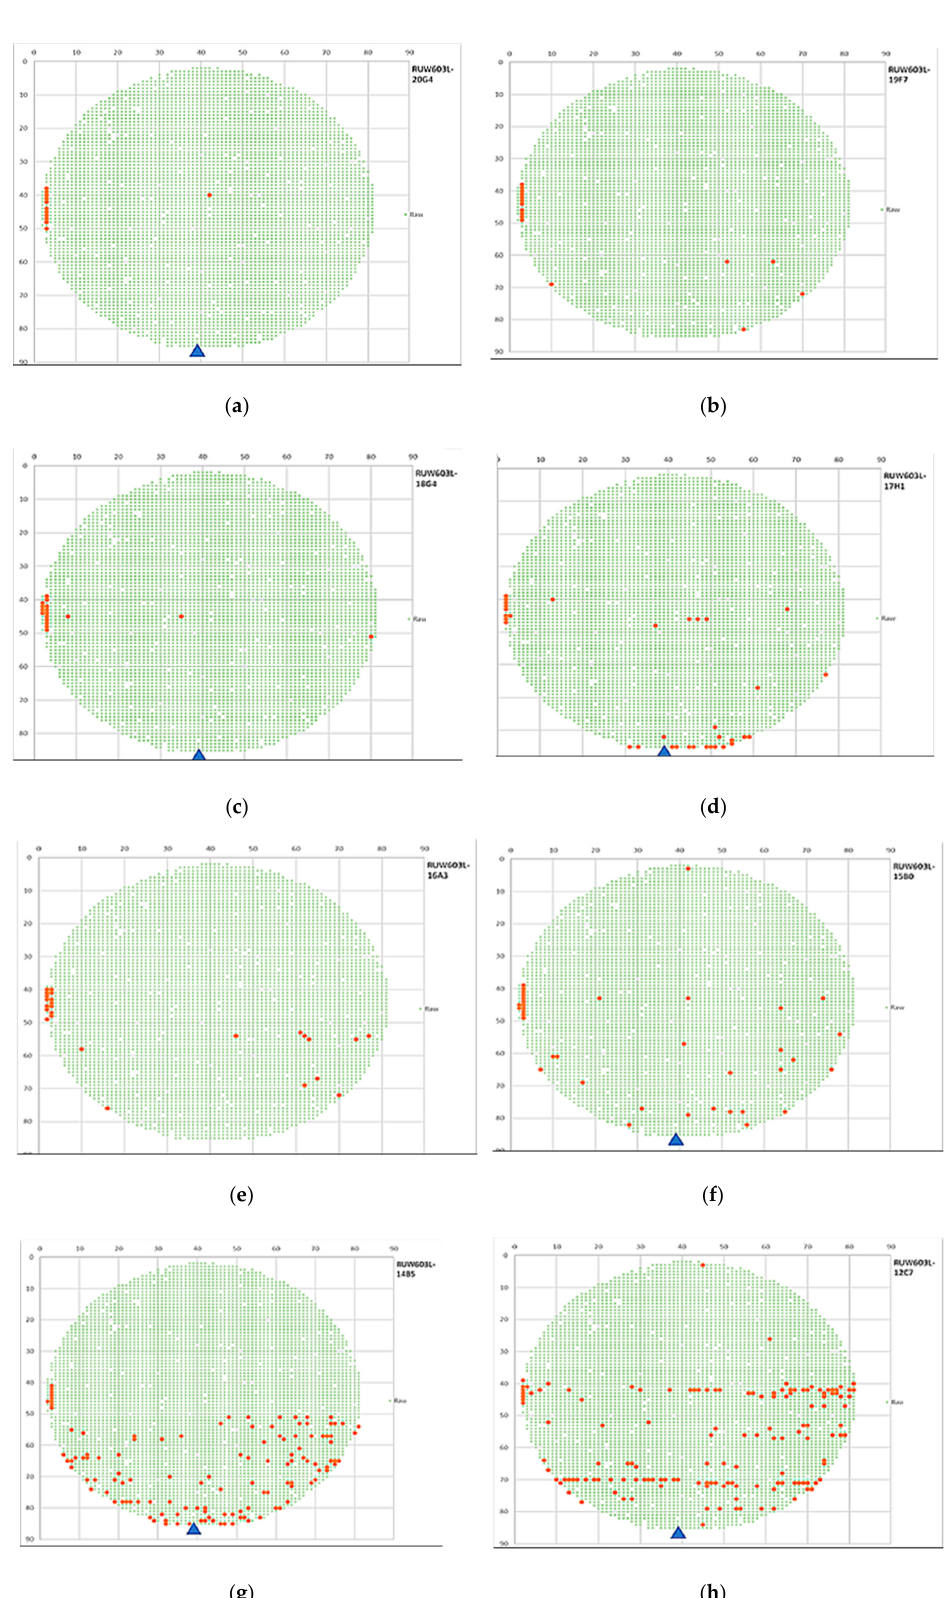
Figure 24. Wafer chipping distribution with tuning parameters where ( a ) grinding of the 1st wafer; ( b ) grinding of the 2nd wafer; ( c ) grinding of the 3rd wafer; ( d ) grinding of the 4th wafer; ( e ) grinding of the 5th wafer; ( f ) grinding of the 6th wafer; ( g ) grinding of the 7th wafer; ( h ) grinding of the 8th wafer. A blue triangle represents the kerf Z1 stopped location. Table 6. Wafer grinding using different approaches.